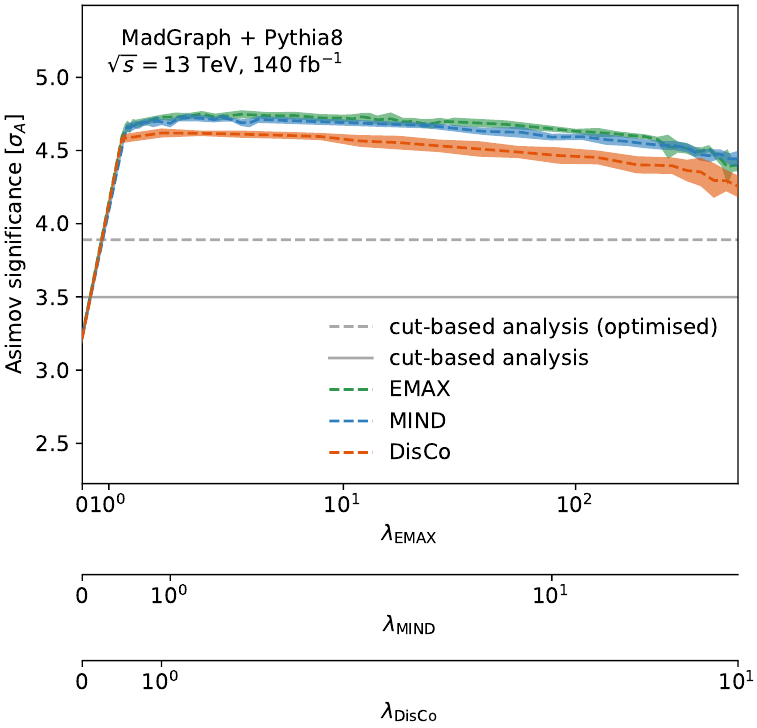
Figure 5 . Asimov discovery signi(cid:12)cance (cid:27) A for V H ! b (cid:22) b in the 0-lepton channel as a function of the hyperparameter (cid:21) , separately for the three investigated DCA strategies. The signi(cid:12)cance expected for the CBA using the original (optimised) cut values is indicated by the grey (dashed) line. For each value of (cid:21) , the dashed line shows the mean signi(cid:12)cance, while the colored uncertainty band corresponds to the sample standard deviation computed from 10 independent training runs. The axis scaling is chosen to highlight the similar behaviour of all three DCA